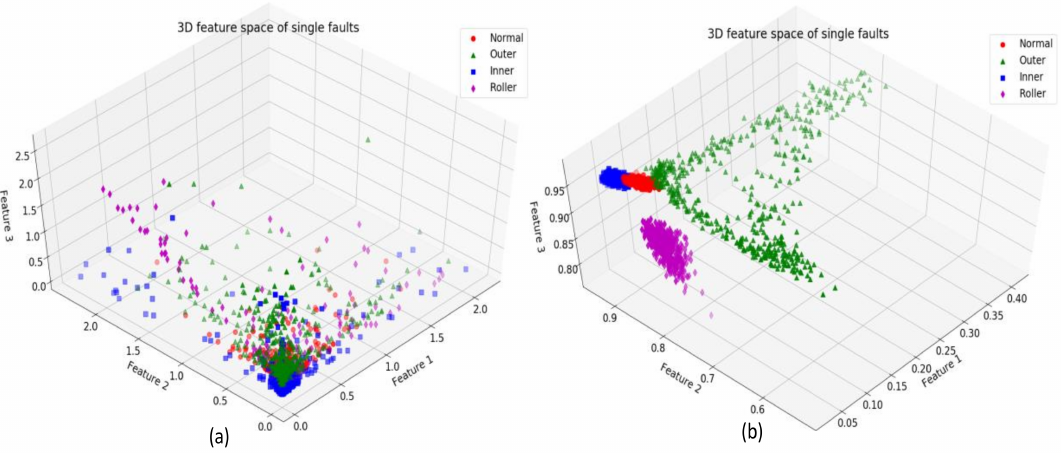
Figure 7. Feature space of the single faults: ( a ) before using stacked denoising autoencoders (SDAE) training and ( b ) after using SDAE